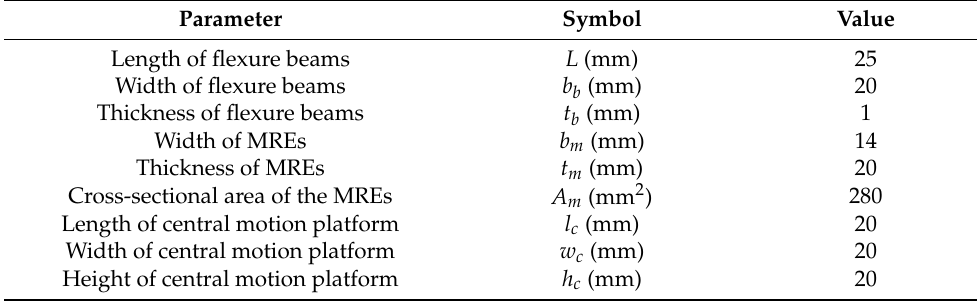
Table 2. Geometric parameters of the nanopositioner.